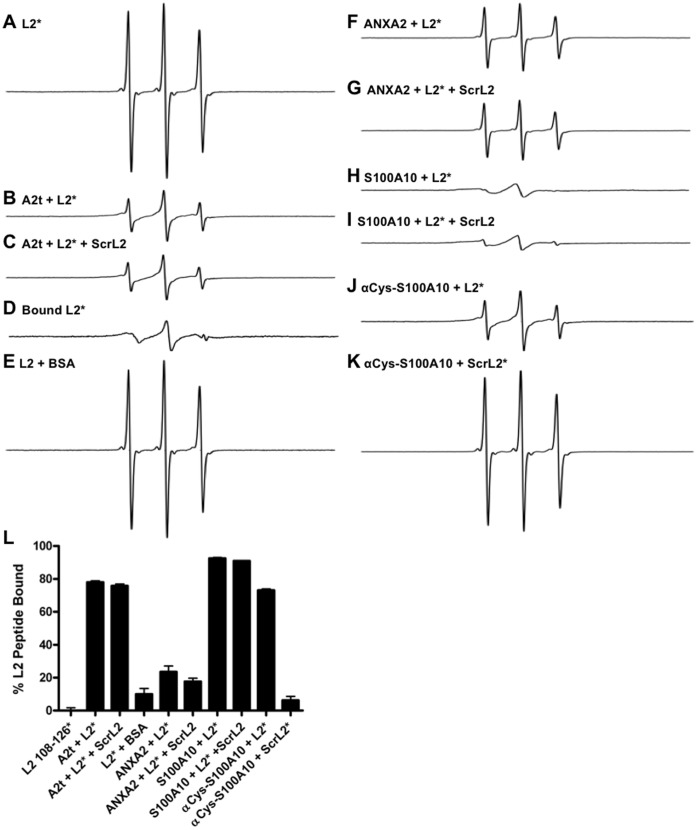
HPV16 L2108–126 peptide binds to the S100A10 subunit of A2t protein with sequence specificity.HPV16 L2 peptide was paramagnetic-labeled (*denotes the attachment of the paramagnetic-label) and analyzed for binding to purified A2t, S100A10 and ANXA2 protein in vitro by electron paramagnetic resonance. (A) The first derivative spectrum of L2108–126 peptide free from ligands in solution. (B) The first derivative spectrum of L2108–126 combined with A2t. (C) The first derivative spectrum of L2108–126 combined with A2t in the presence of the control peptide (5∶1). (D) The result of subtraction of spectrum A from spectrum B representing the bound spectrum of the labeled peptide. (E) The first derivative spectrum of L2108–126 combined with BSA. (F) The first derivative spectrum of L2108–126 combined with ANXA2. (G) The first derivative spectrum of L2108–126 combined with ANXA2 in the presence of the scrambled peptide (5∶1). (H) The first derivative spectrum of L2108–126 combined with S100A10. (I) The first derivative spectrum of L2108–126 combined with S100A10 in the presence of the scrambled peptide (5∶1). (J) The first derivative spectrum of L2108–126 combined with cysteine-blocked S100A10 (αCys-S100A10). (K) The first derivative spectrum of the paramagnetic-labeled scrambled peptide combined with cysteine-blocked S100A10. (L) Quantification of relative % bound of all treatments as measured through spectra subtraction and double integration expressed as the mean of three separate experiments ± SD.